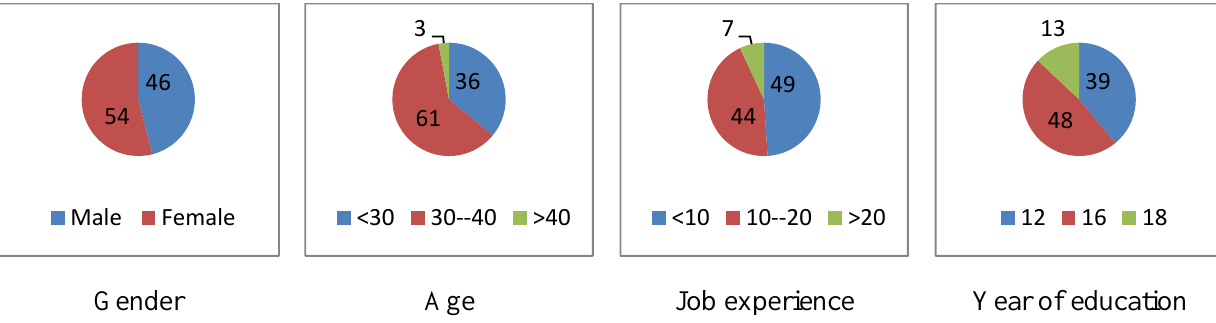
Fig. 2. Personal characteristics of the